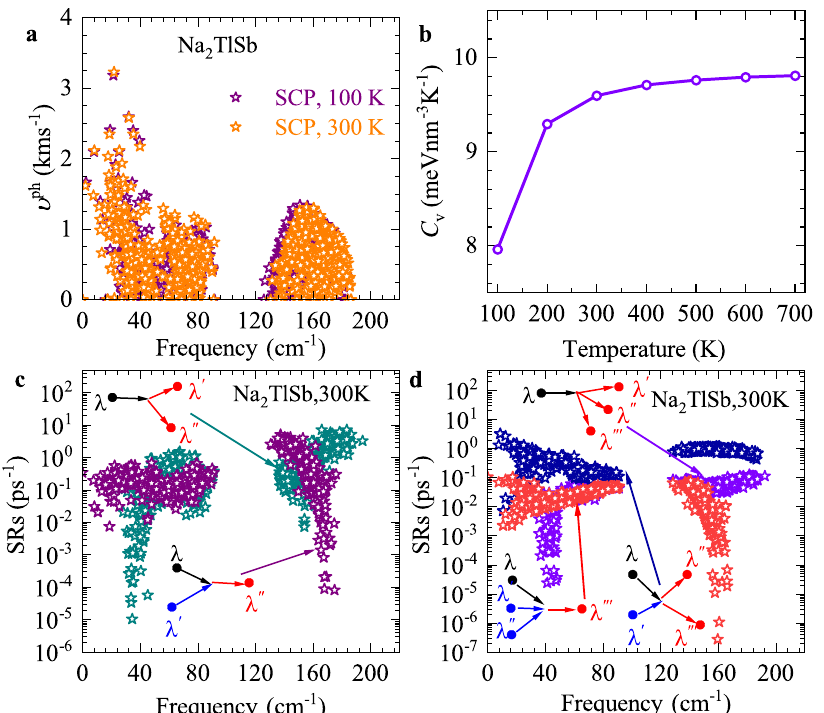
Fig. 3 Phonon transport parameter. a The phonon group velocity υ ph at 100 and 300 K. b The calculated speci fi c heats C V . c Decomposed 3ph scattering rates into the slitting ( λ ! λ 0 þ λ 00 ) and combination ( λ þ λ 0 ! λ 00 ) processes at 300 K. d Decomposed 4ph scattering rates into the splitting ( λ ! λ 0 þ λ 00 þ λ 000 ), redistribution ( λ þ λ 0 ! λ 00 þ λ 000 ), and combination ( λ þ λ 0 þ λ 00 ! λ 000 ) processes at 300 K. All of the above results were obtained using SCP